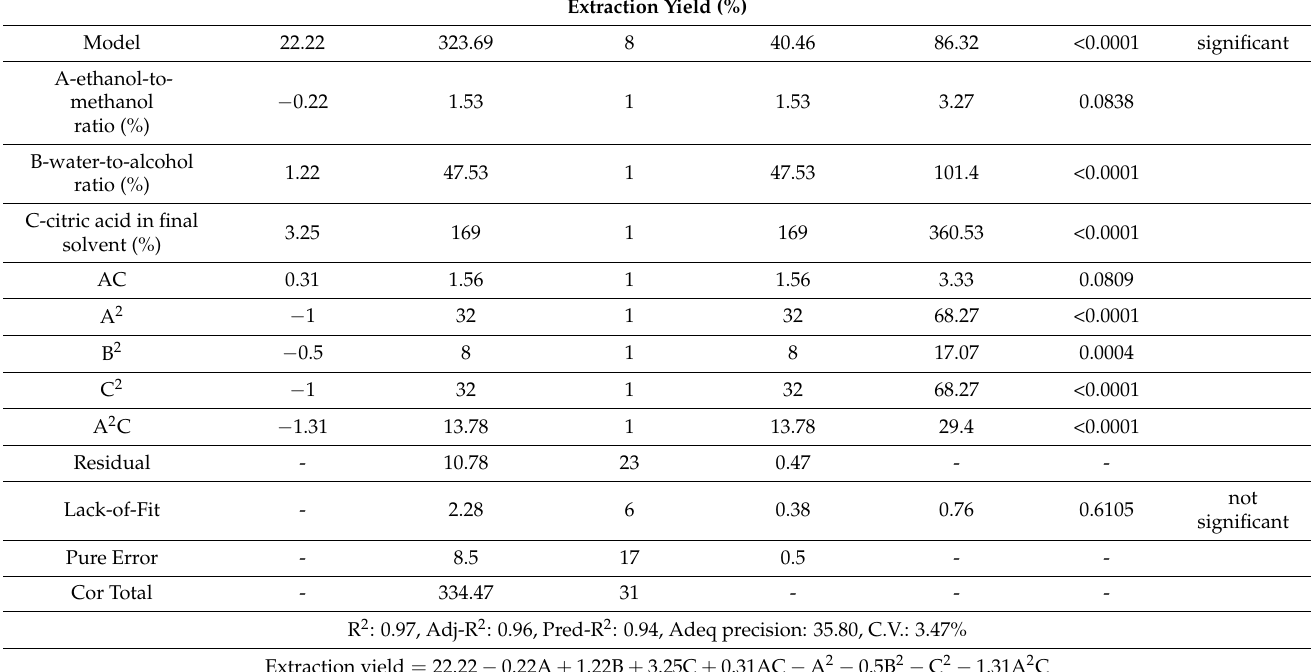
Table 4. The analysis of variance (ANOVA) of extraction yield (third-order fitted polynomial model) in bioactive compound extraction of eggplant peel by the different solvent